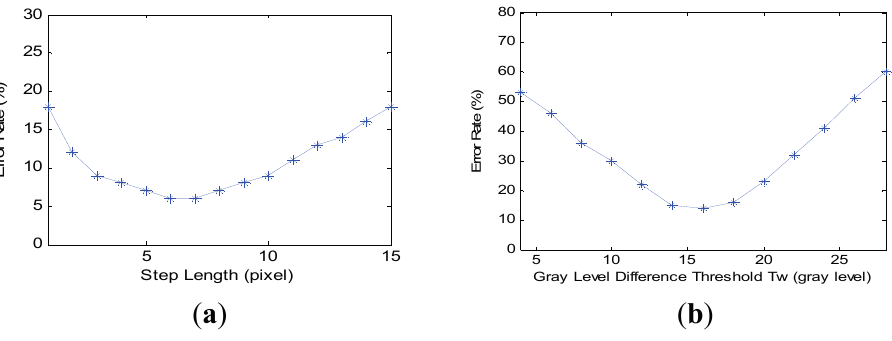
Figure 13. Error rate of the crack quantification method: ( a ) results of length quantification; ( b ) results of width